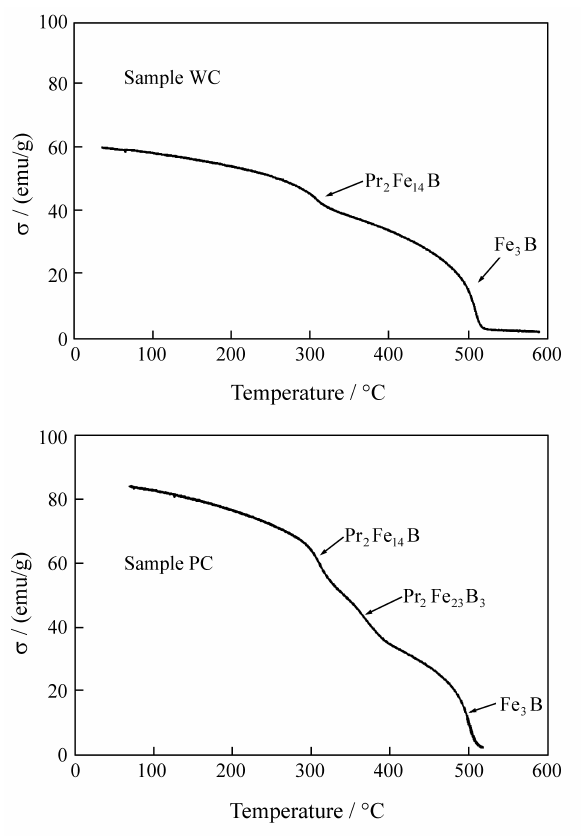
Figure 8. Specific magnetization vs. temperature T for samples WC and